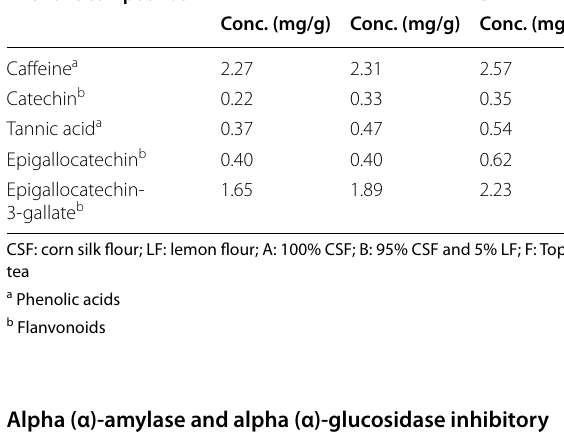
ACE (higher than 50%).